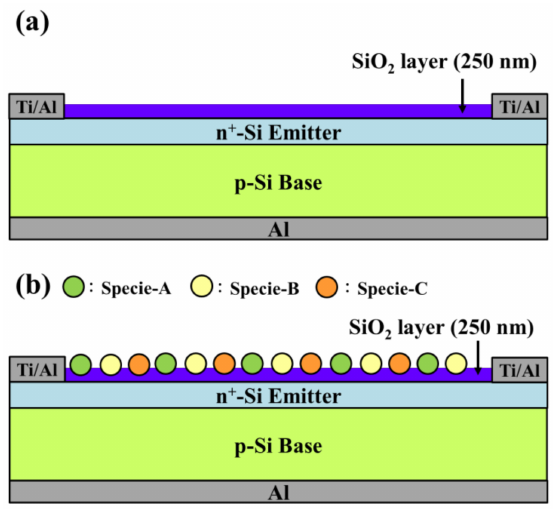
Figure 1. Schematic diagram showing silicon solar cell coated with ( a ) 250-nm-thick SiO 2 layer; ( b ) luminescent down-shifting (LDS) layer (SiO 2 layer comprising three species of Eu-doped silicate